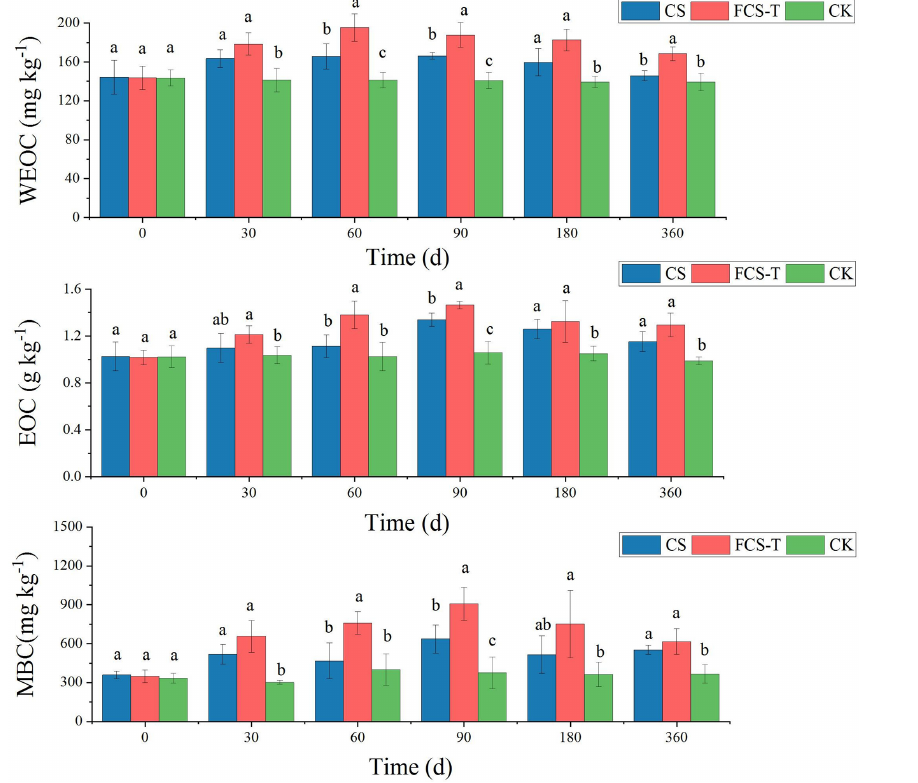
Figure 3. Effects of corn straw returned (CS), fermented corn straw treated with T. reesei returned (FCS-T), and non-straw amended soil (CK) on soil labile organic carbon (WEOC, EOC, and MBC) concentrations in the 0–20cm soil depth. Each bar represents the mean ± standard deviation in the figure ( n = 3). Different lowercase letters within the same time indicate significant differences among different treatments at P < 0 . 05 level.